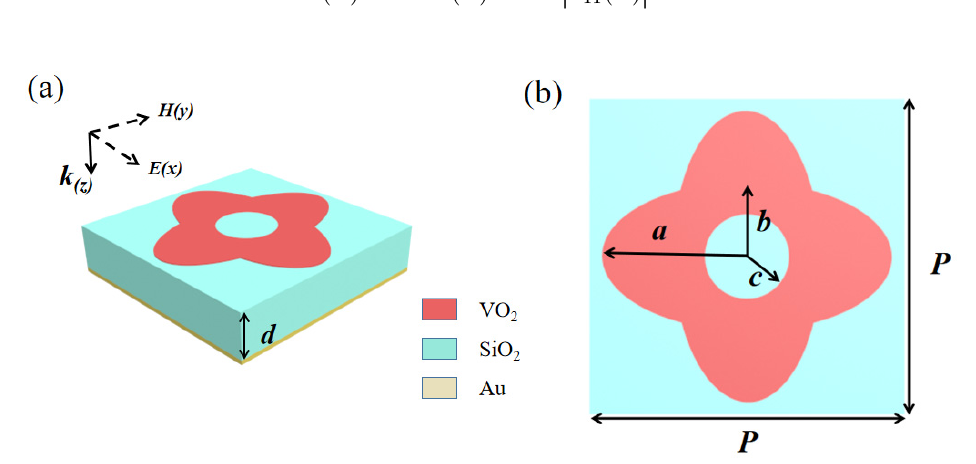
Figure 1. ( a ) Three-dimensional schematic of the absorber. ( b ) Top view of the unit cell.